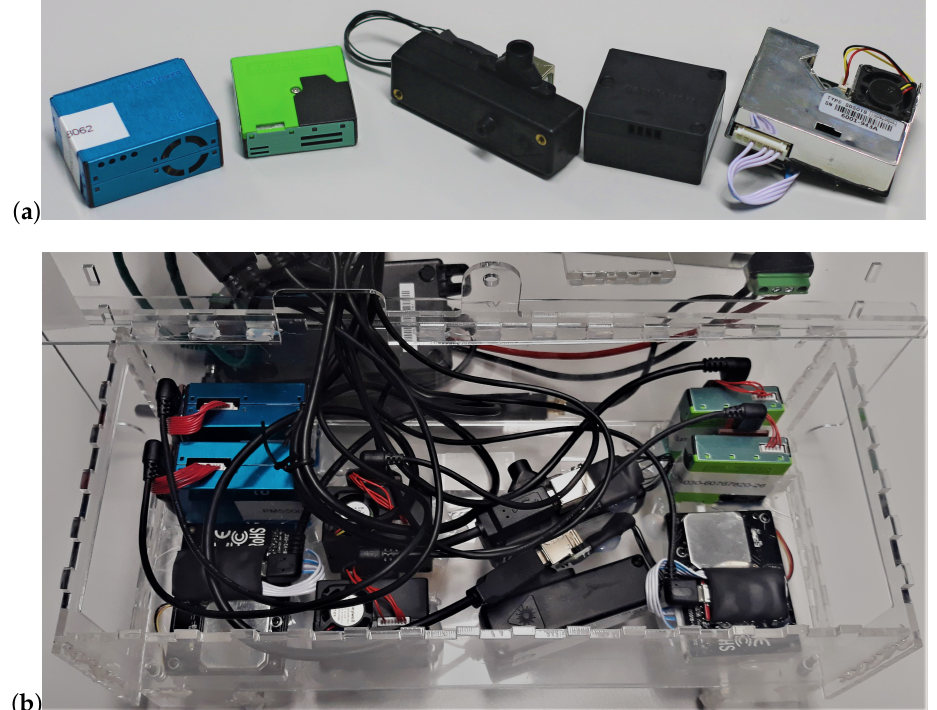
Figure 1. ( a ) Picture of the sensors tested from left to right: Plantower PMS5003, Sensirion SPS030, Alphasense OPC-R1, Honeywell HPMA115S0 and Novafitness SDS018. ( b ) Position of the sensors tested within each air quality monitor. From left to right, top to bottom: two Plantower PMS5003, one Novafitness SDS018, two Honeywell HPMA115S0, two Alphasense OPC-R1, two Sensirion SPS030 and one Novafitness SDS018. All the inlets are facing